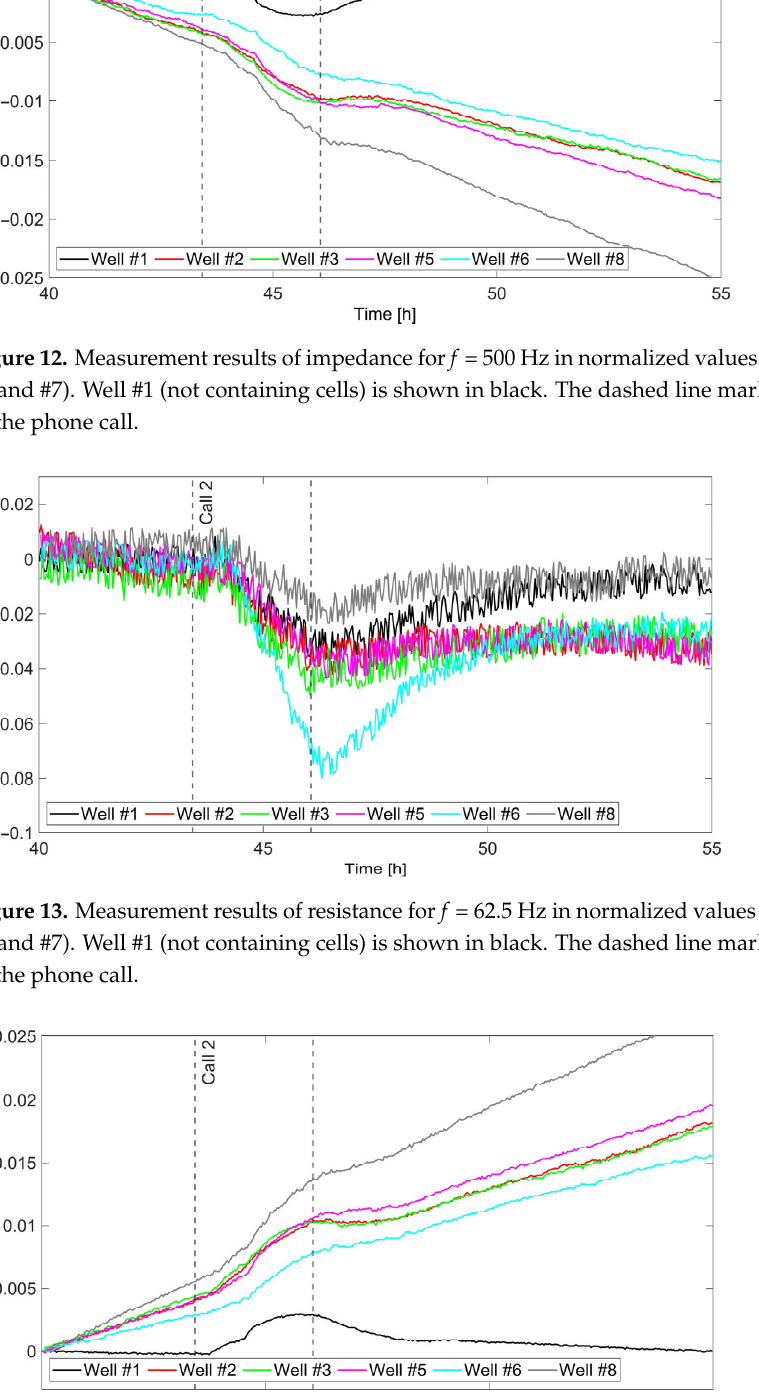
11 of 14 Figure 11. Results of normalized capacitance measurements for the signal with f = 64 kHz, measured during 93 h of cell culture duration. An analysis of the results obtained for different frequencies was carried out. After normalization of the values of impedance, resistance, and capacitance for much lower sig ‐ nal frequencies, significant changes due to the presence of the electromagnetic field in the vicinity of the cell culture could be observed. The most noticeable changes were observed for the phone call which lasted the longest (144 min). All measured electrical parameters clearly changed their value after the phone call started, and their values returned to those before the call after the call ended (Figures 12–14). For clarity, wells #4 and #7 were not included in the graphs because they contained values that distorted the other results. The results were selected for the frequencies at which changes in the measured values were the most significant. The values of impedance at f = 500 Hz and resistance at f = 62.5 Hz